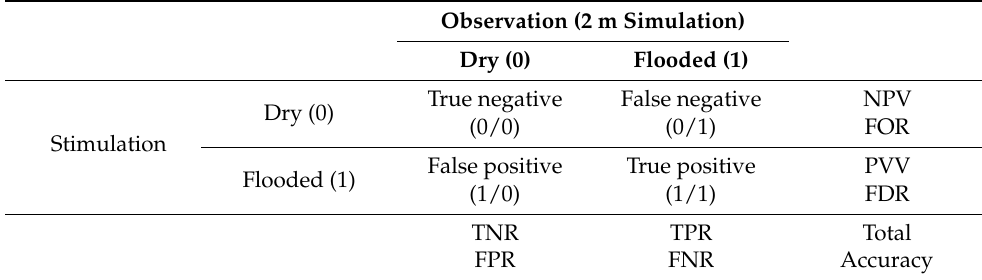
Table 1. Schematic of confusion